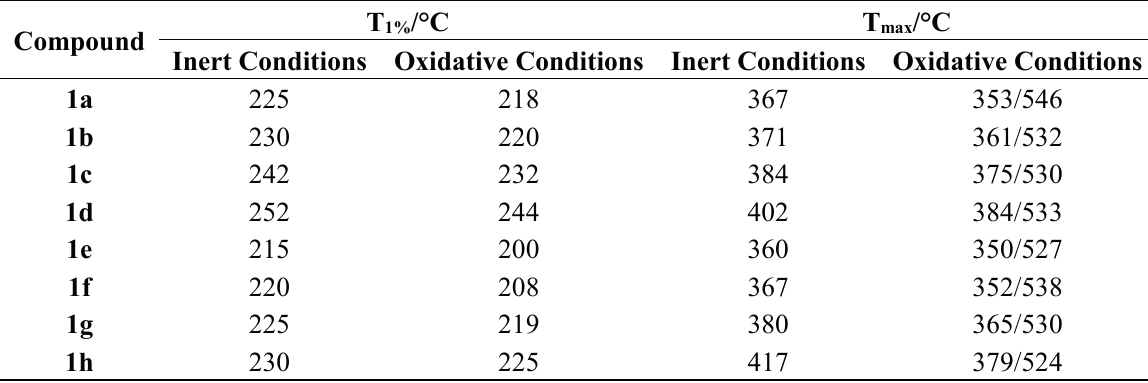
Table 2. Thermal properties of esters under inert and oxidative